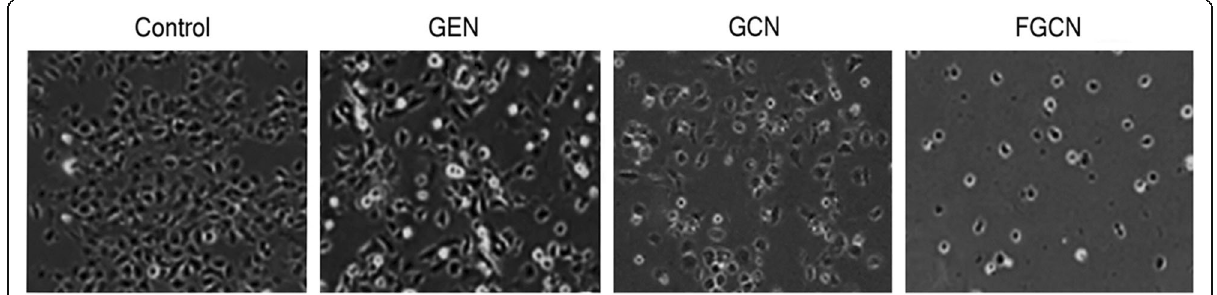
Fig. 6 Morphological analysis of HeLa cancer cells after treatment with GEN, GCN, and